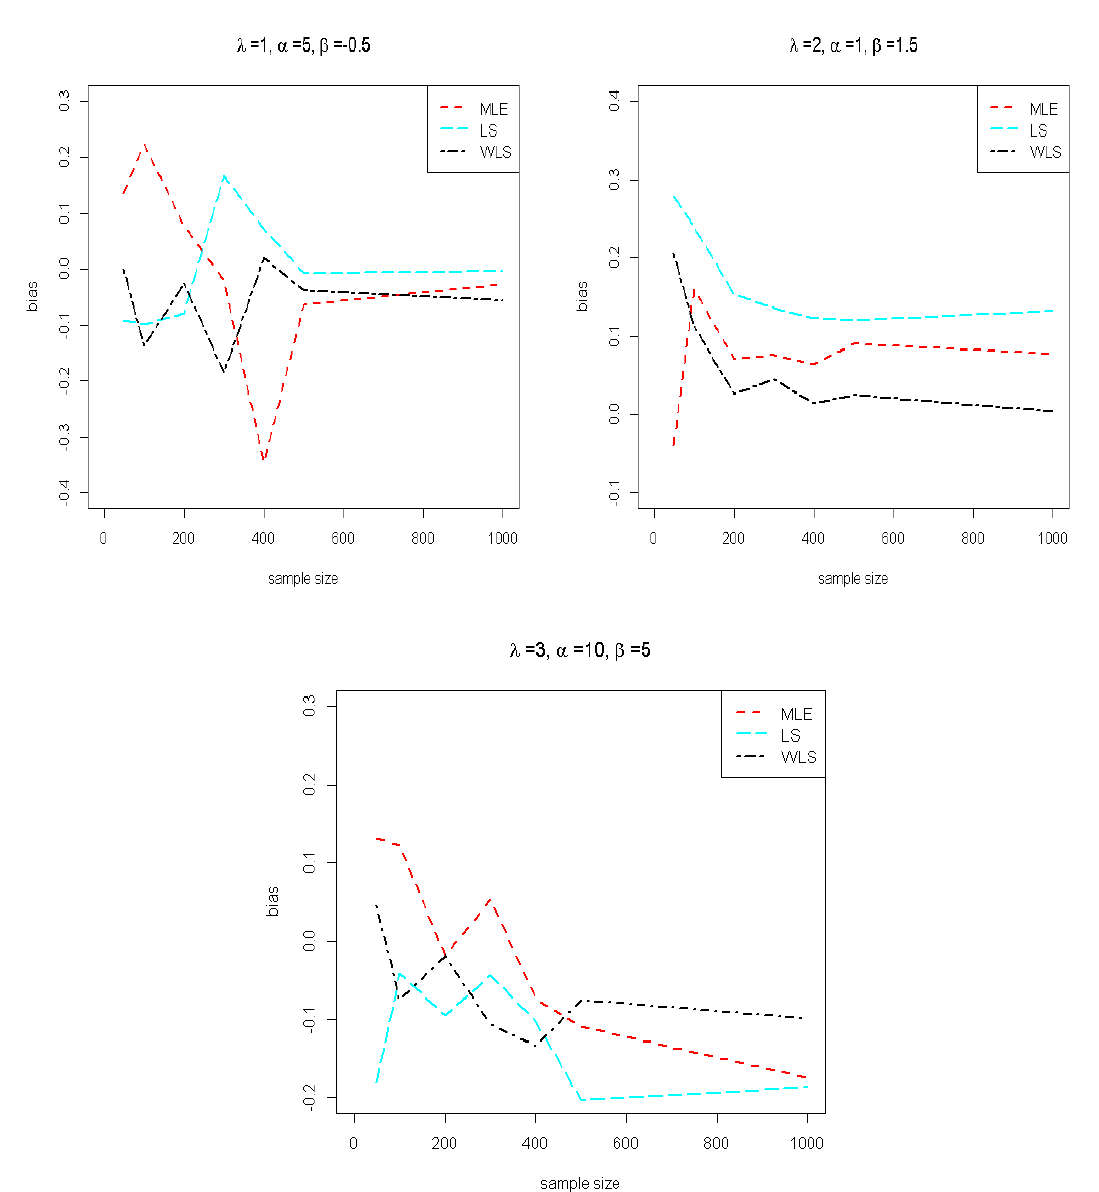
Figure 6. Bias of estimator ˆ θ versus sample size n for different